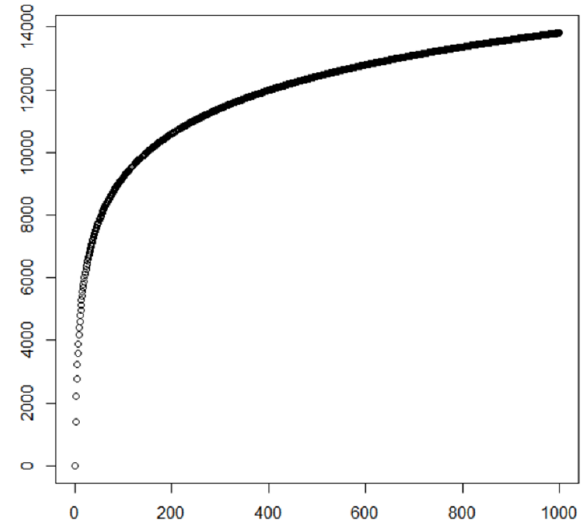
Figure 13. Greedy algorithm: Best’ graph using R Studio. (X axis: Number of nodes, Y axis: Amount of calculation).